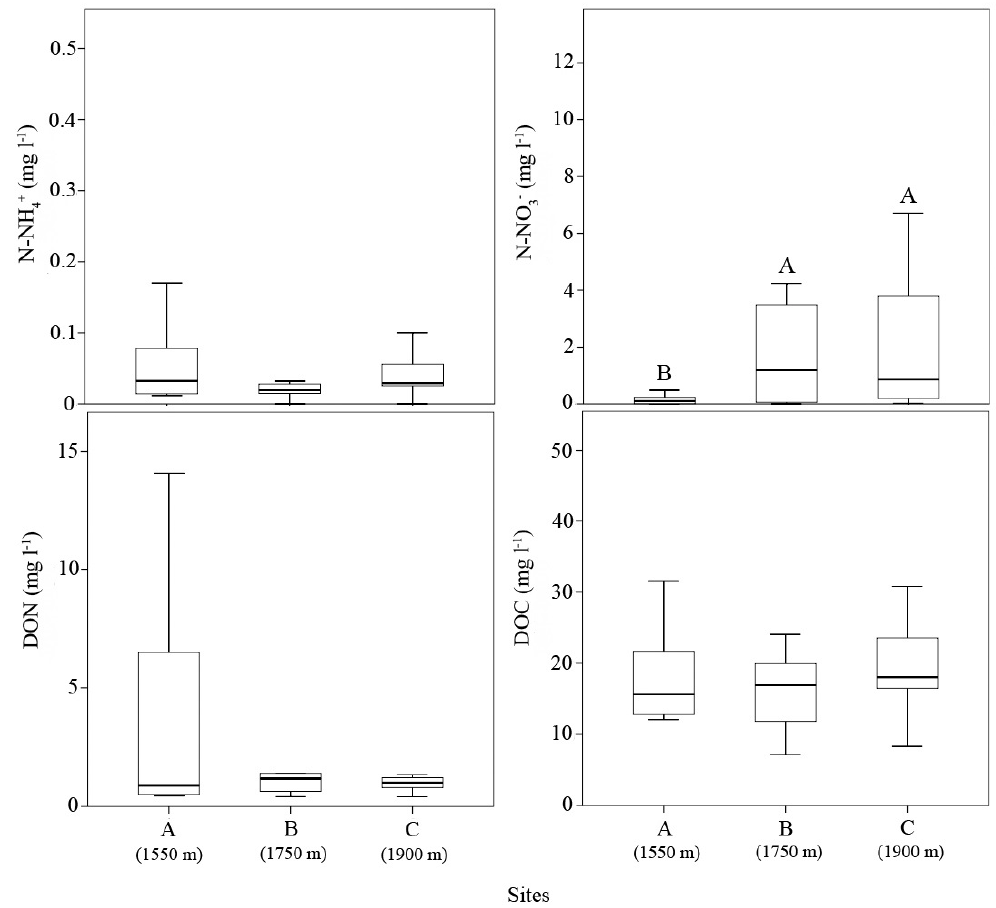
Figure 6. Soil solution N-NH 4 + , N-NO 3 − , DON, and DOC (mg L − 1 ) in the 3 study sites (mean values of 2015 and 2016 snow-free seasons), n = 27. Letters, where included, indicate significant differences ( p < 0.05) between sites.